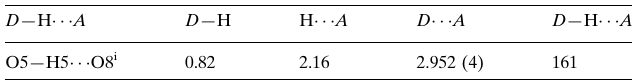
Hydrogen-bond geometry (A˚ , (cid:4) ). D —H (cid:1)(cid:1)(cid:1)